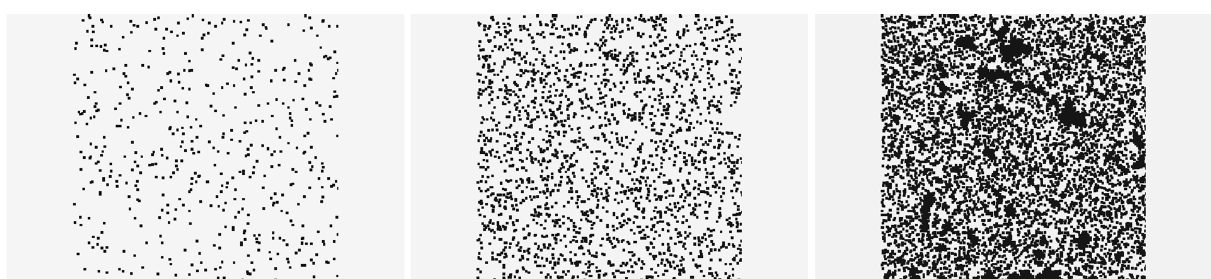
0.95, 0.8 and 0.5 (from left to right), size Figure 2. Exemplary random porous samples at porosity ϕ = 800 400 . Black blocks represent obstacles for the flow, while the interconnected light gray area is the pore × 0.5 , are the effect of the filling-gap algorithm used for space filled by fluid. Black clusters, visible for ϕ = prepossessing of the data, after generating with random deposition procedure. The gaps are not accessible for the fluid and, thus, we fill them before they are provided to the fluid solver and neural